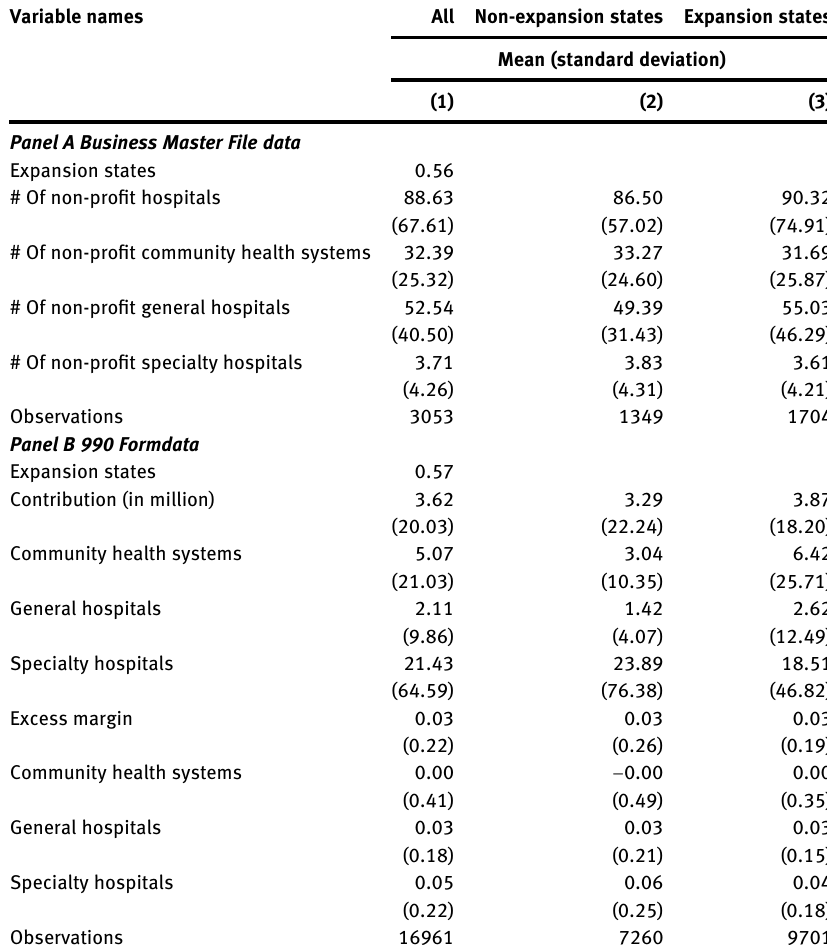
Table  a: Descriptive statistics for outcome